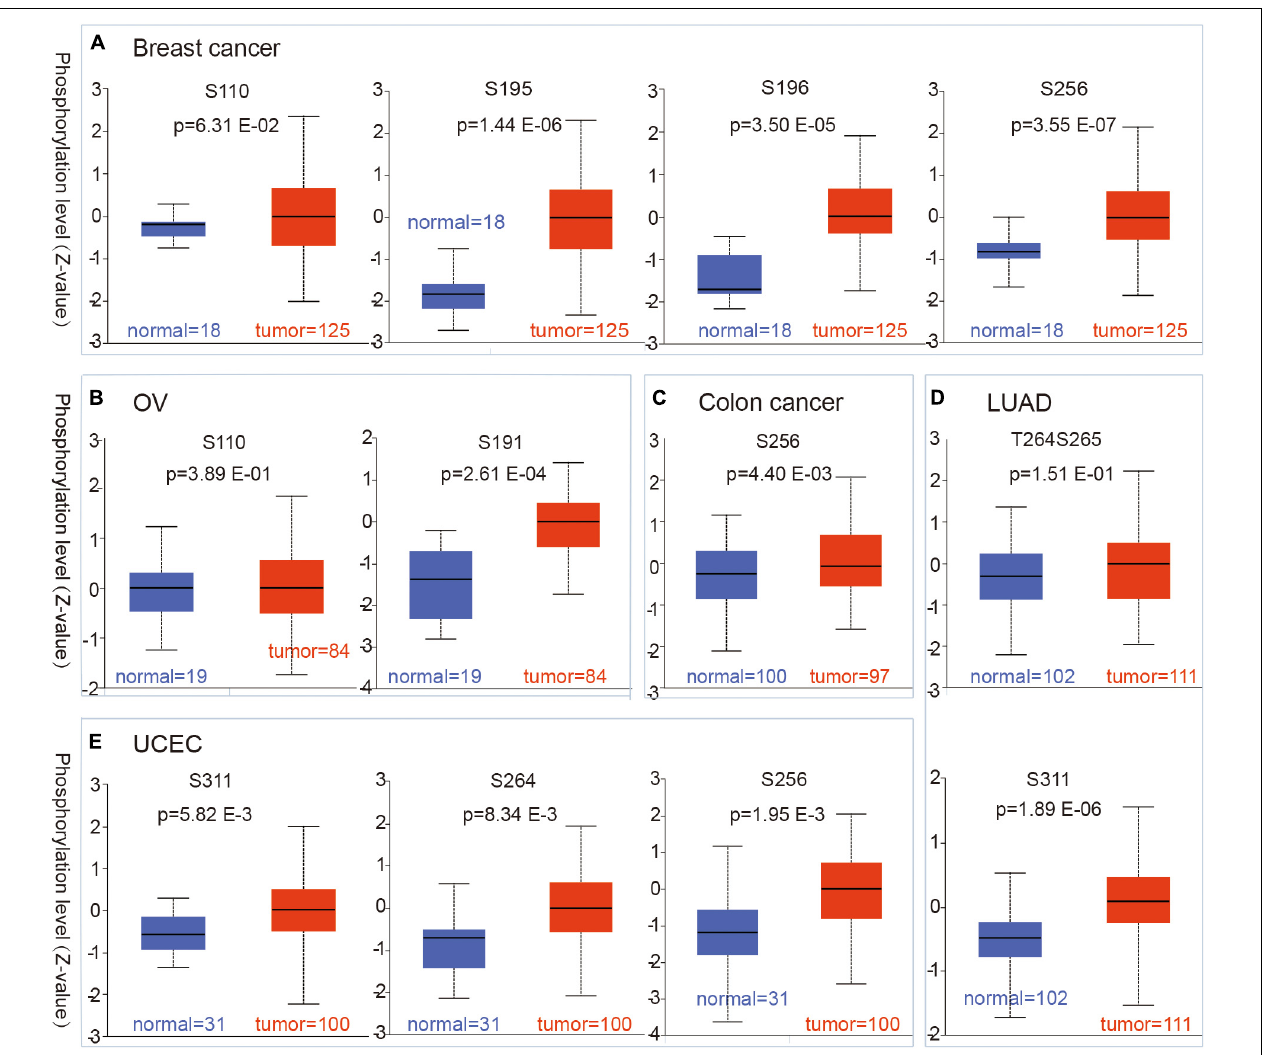
FIGURE 4 | Phosphorylation status of CBX8 protein in different cancers. Based on the CPTAC dataset, the differences in expression of CBX8 phosphoprotein (including phosphorylation sites S191, S195, S196, S256, S264, and S311) between normal tissue and primary tissue from selected tumors are detected via the UALCAN, which was visualized by box plots. (A) Breast cancer. (B) Ovarian cancer. (C) Colon cancer. (D) LUAD. (E)